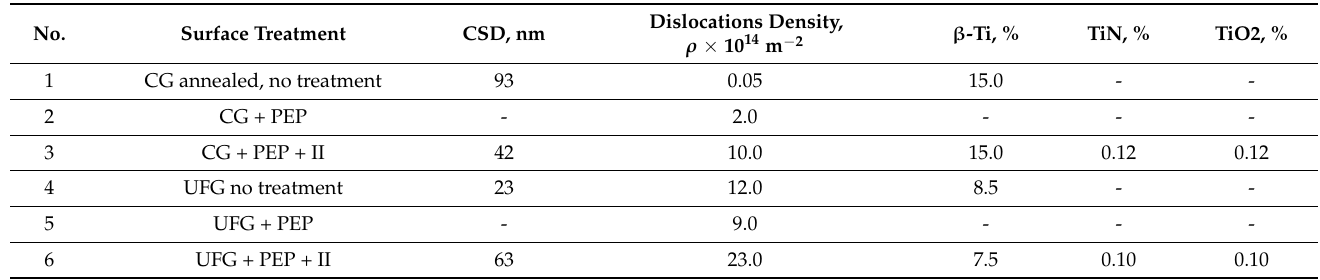
Figure 4. Microstructure of Ti ‐ 6Al ‐ 4V alloy in the UFG state: general view of the structure, SEM ( a ); ( α + β ) area of a mixture of ultrafine grains, TEM ( b ). Table 2. Results of X-ray